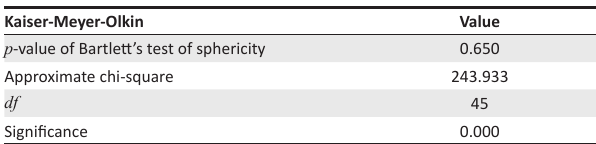
TABLE 4: Kaiser-Meyer-Olkin and Bartlett’s test of sphericity.